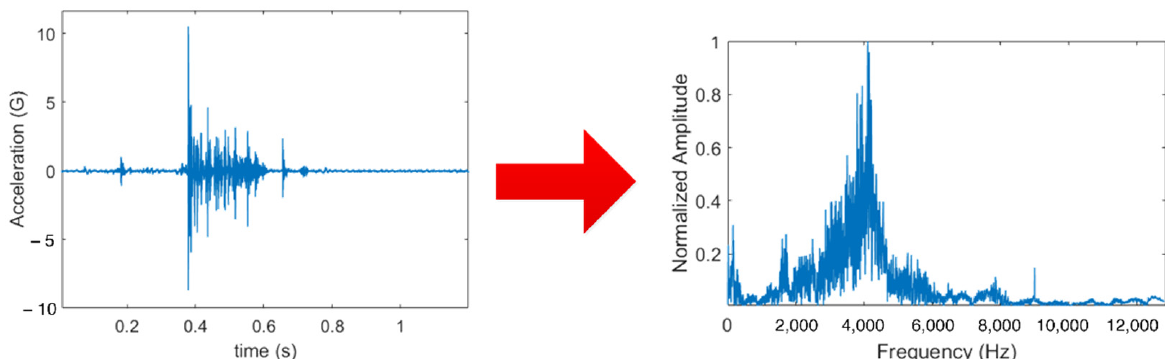
Figure 6. Data transformation from time based to frequency